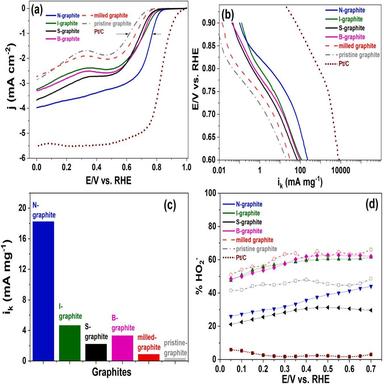
RRDE ORR polarization curves and mass-transport corrected Tafel plots (a,b) of the doped-graphite catalysts in O2 saturated 0.10 M KOH aqueous solution acquired at a potential scan rate of 2.00 mV s -1 with a rotational speed of 1600 rpm. Mass-transport corrected mass activity (mA mg− 1 ) at 0.75 V (c). Percentage of peroxide detected at the ring (d). The data is not corrected for the ohmic loss. For the control experiment, the ORR polarization curves of pristine, and milled graphite were recorded at 5.00 m